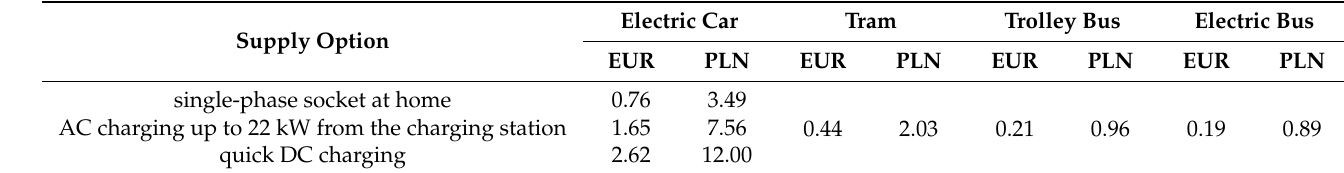
Table 9. The cost of traveling 100 km per 1 passenger.